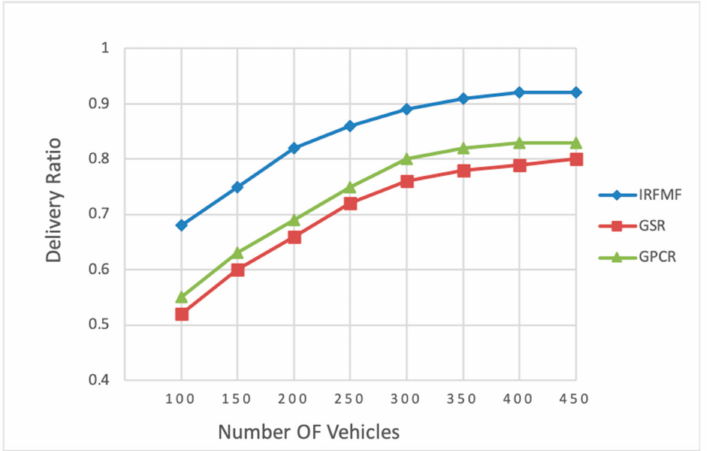
Figure 6. Comparison chart of packet delivery ratio of the three protocols with different numbers of vehicles.